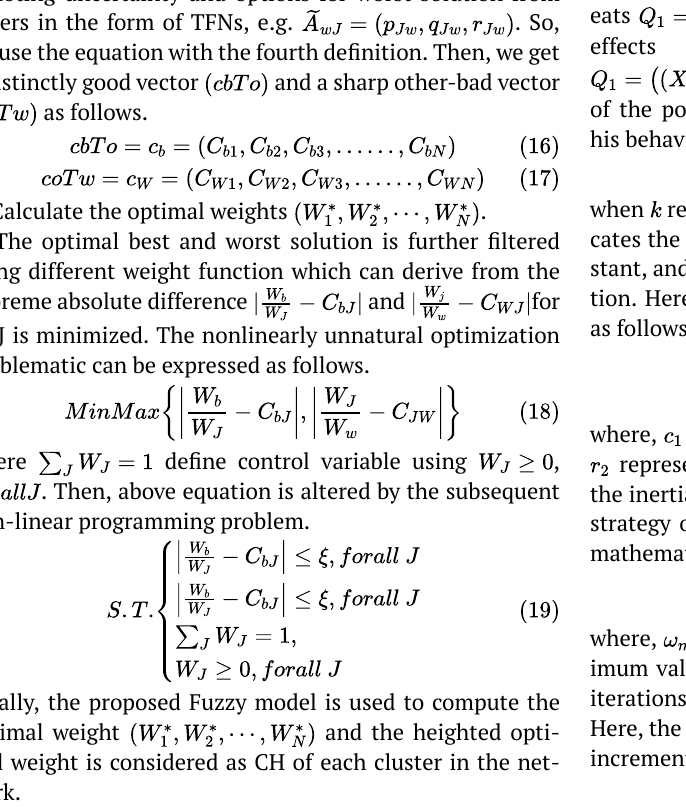
denoting uncertainty and options for worst solution from others in the form of TFNs,